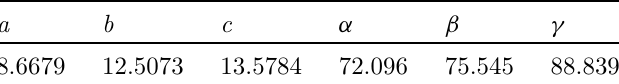
Table 3. Unit cell lengths ( a, b, c ) in A (cid:3) and angles ( a , b , g ) in degrees for crystalline IDIC used in this work.